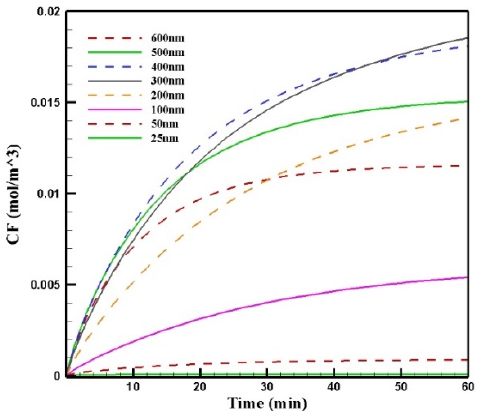
Figure 13. Comparison of the mean concentrations of the free drug (CF) in the tumor over 60 min of treatment using magnetically controlled IP chemotherapy for different nanoparticle sizes.